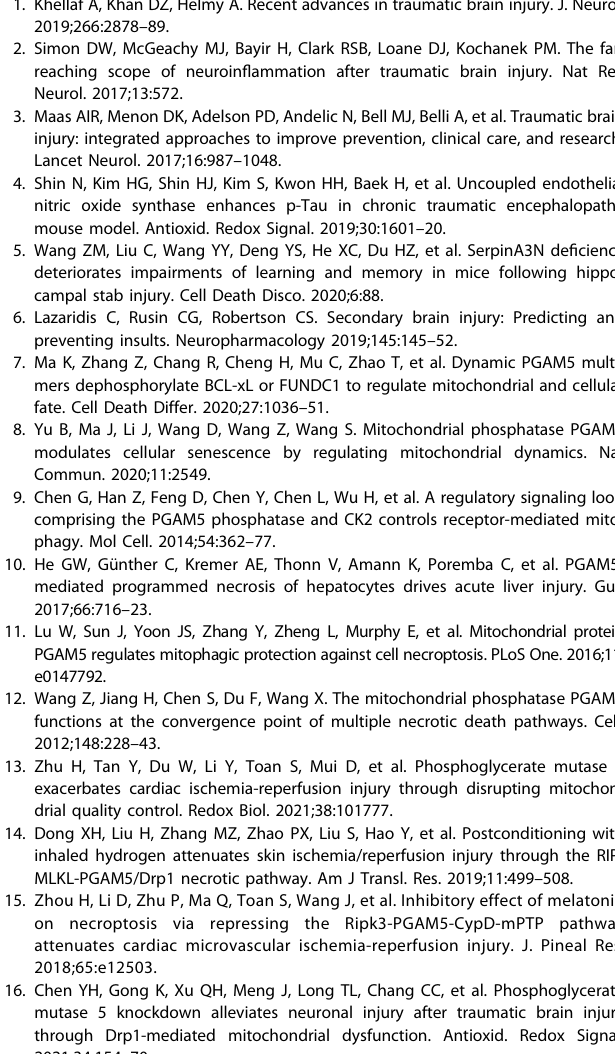
Fig. 4 Pgam5 is required for microglia-induced Il-1 β secretion and Asc oligomerization. NO production was detected by the ( A ) Griess reaction and cell viability was measured by (B) CCK8 assay. ( A ) * p < 0.001 compared to the control group and # p < 0.001 compared to the LPS group, by two-way ANOVA followed by Tukey ’ s post hoc multiple comparison test. C Primary microglia were primed with LPS for 4 h prior to stimulation with ATP for 30 min, and Il-1 β secretion was determined by ELISA. D Dynamically monitor Il-1 β level in LPS-primed microglia treated with ATP for the indicated amount of time. C , D * p < 0.001 compared to the NC-sh group and # p < 0.001 compared to the Pgam5 - sh group, by two-way ANOVA followed by Tukey ’ s post hoc multiple comparison test. ( E ) Whole-cell extracts were subjected to Western blot analysis. Microglia were stimulated with LPS + ATP and the mRNA of ( F ) cytokineand ( G ) pyroptosis-related genes were determined by qRT- PCR. * p < 0.001 compared to the WT group by one-way ANOVA followed by Tukey ’ s post hoc multiple comparison test. Data shown are mean ± SEM ( n = 4). Pgam5-shRNA and caspase8-shRNA microglia were stimulated with LPS + ATP. H Results of immunoblotting with antibodies to the indicated proteins and immunoprecipitated with anti-Asc. I The detergent-insoluble fraction was subjected to chemical cross-linking,